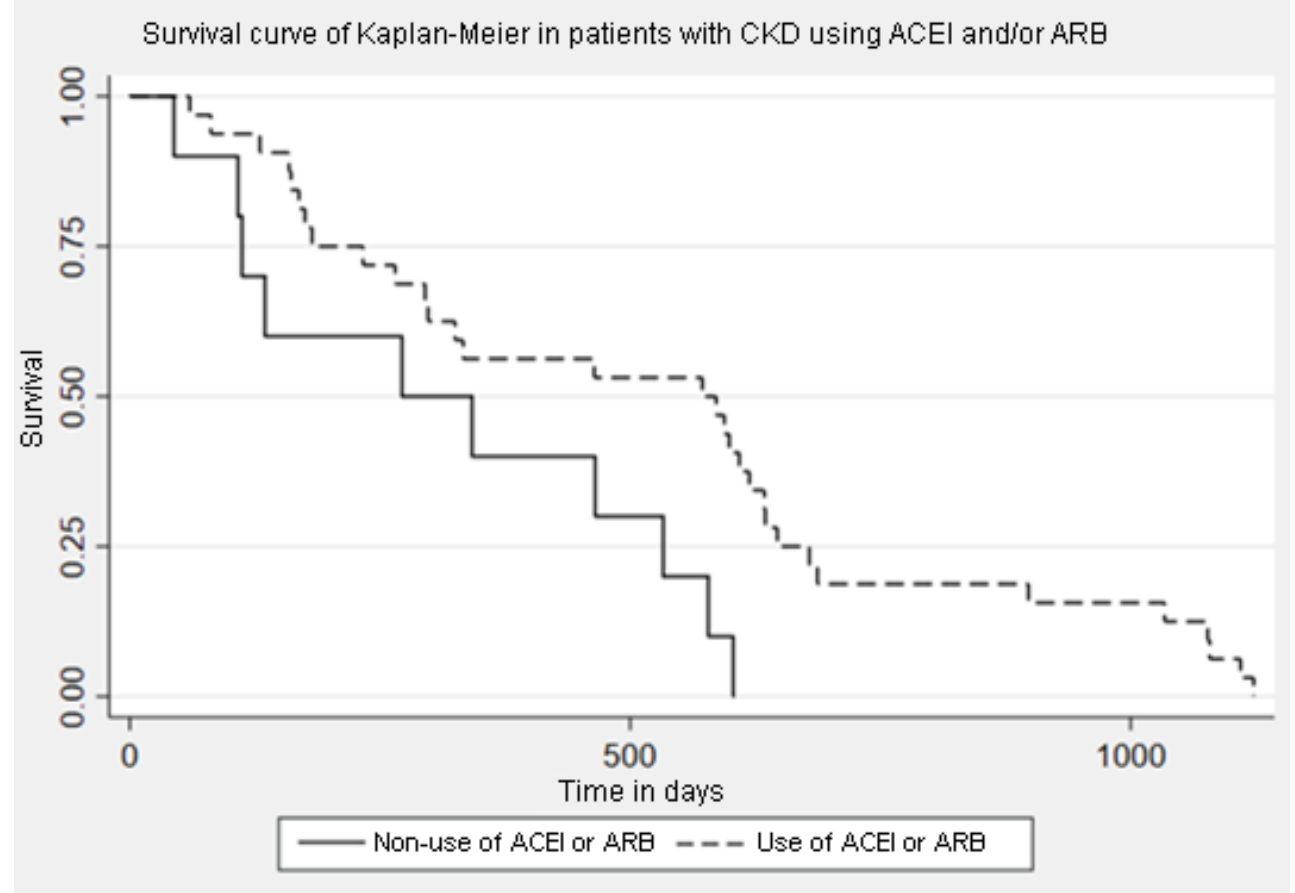
FIGURE 4 - Survival curves estimated by the Kaplan-Meier methods in patients with chronic kidney disease, by exposure or not to the use of ACE inhibitors or